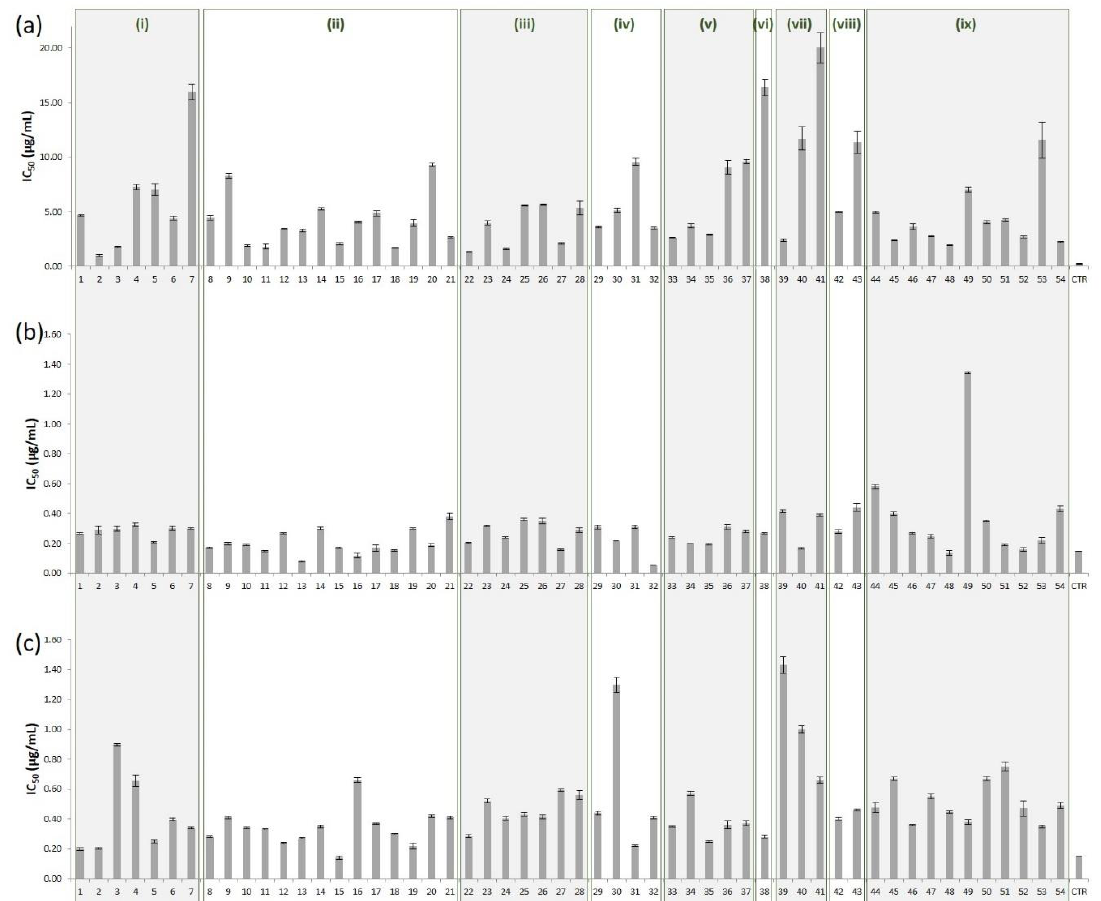
Figure 1. Graphical representation of the antioxidant activity (expressed as IC 50 in μg/mL) exerted by ( a ) the essential oils, ( b ) the organic (CH 2 Cl 2 /EtOH 2:1) and ( c ) the hydroethanolic (EtOH/H 2 O 1:2) extracts of the fresh needles of 54 Pinus taxa, in comparison to that of the positive control (CTR: β -carotene for ( a ) and quercetin for ( b ) and ( c )). The various boxes represent the following subsections: (i) Pinaster , (ii) Pinus , (iii) Australes , (iv) Contortae , (v) Ponderosae , (vi) Balfourianae , (vii) Cembroides , (viii) Gerardianae , (ix) Strobus .